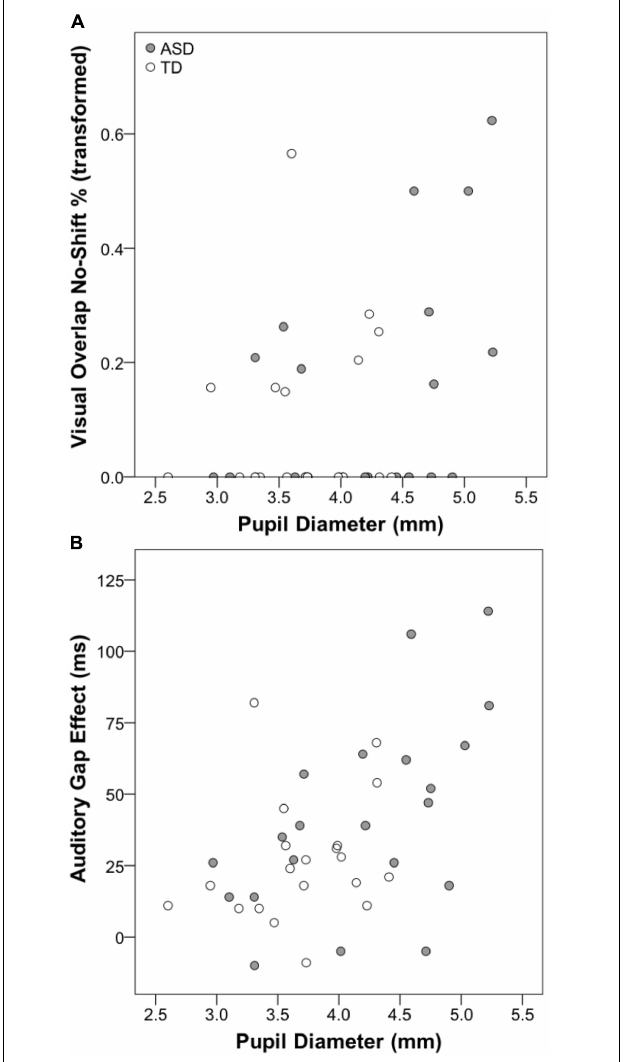
FIGURE 4 | Scatterplots displaying associations between resting pupil diameter and visual gap-overlap task no-shift percentage (A) and auditory gap-overlap task gap effect score (B)